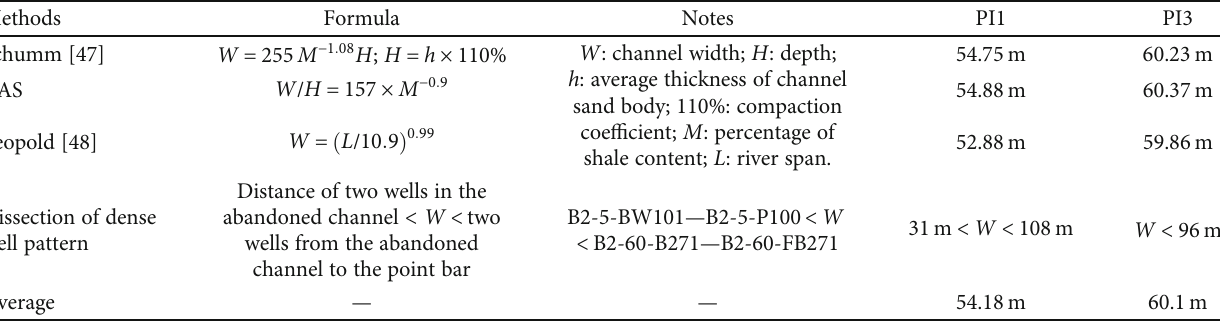
Figure 3: Cores of well B2-60-GB271 from PI1 to PI5+6, 1146m-1173 m. Siltstone is the main oil-bearing reservoir. Five interlayers are within the layer (red dotted line). The numbers on the core represent the sample numbers. Table 1: Methods for calculating channel width.